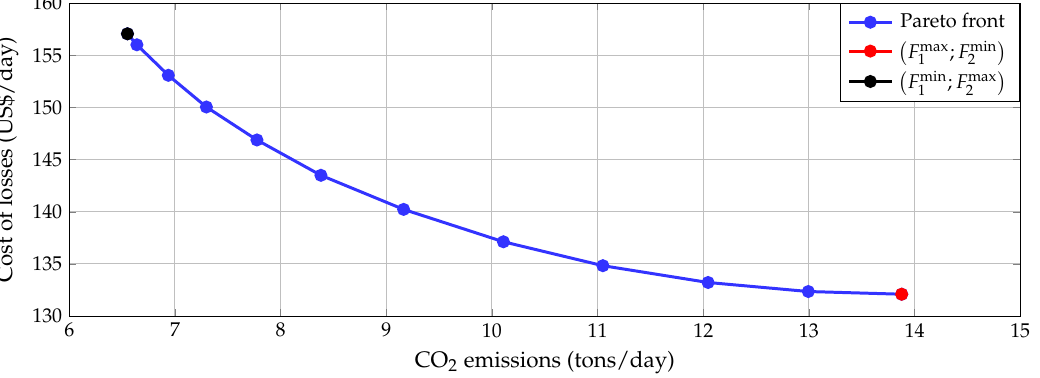
Figure 2. Pareto front for the BESS operation with a unity power